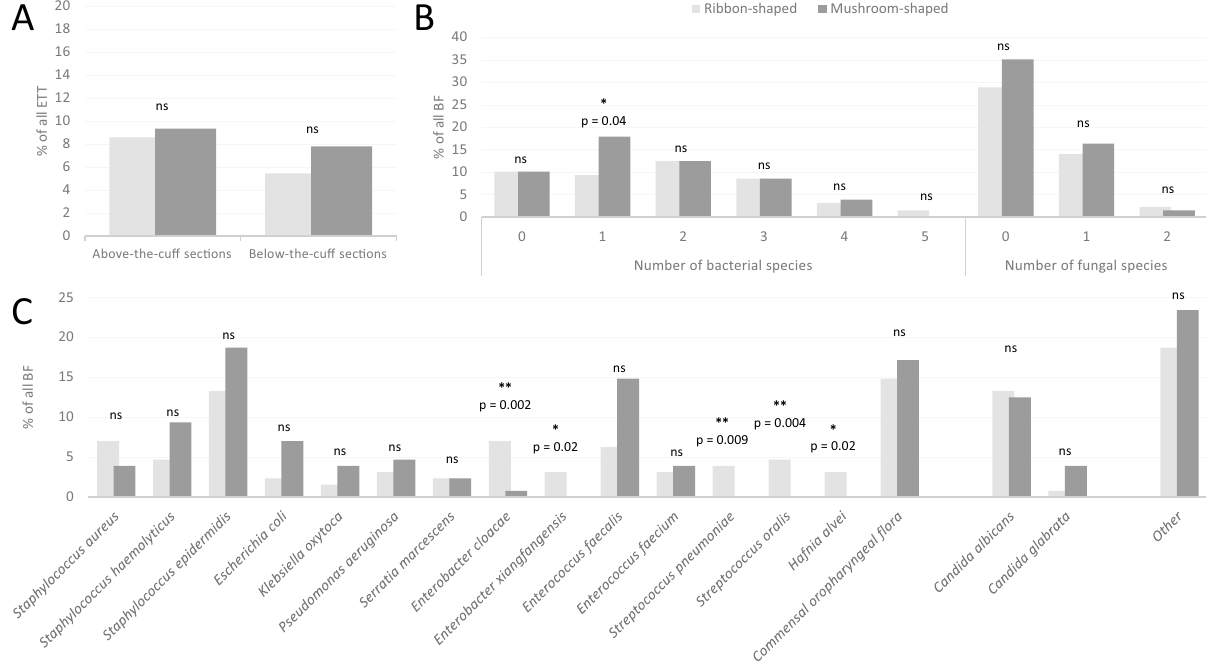
Figure 3. Microbiological characterization of ribbon- and mushroom-shaped ETT-deposited BF. ( A ) compared percentage of ETT retrieving both bacterial and fungal species between ribbon- and mushroom- shaped ETT-deposited BF ; ( B ) compared number of both bacterial and fungal species between ribbon- and mushroom-shaped ETT-deposited BF ; ( C ) compared distribution of both bacterial and fungal species between ribbon- and mushroom-shaped ETT-deposited BF. BF biofilm, ETT endotracheal tube, ns not significant. Other (microbiological species retrieved < 5%) : Candida kefyr , Candida lusitaniae , Candida parapsilosis , Candida tropicalis , Citrobacter freundii, Enterobacter cancerogenus, Enterococcus durans, Klebsiella aerogenes , Klebsiella variicola , Lactobacillus gasseri, Lactobacillus paracasei, Lactobacillus rhamnosus , Morganella morganii, Neisseria mucosa, Propionibacterium acnes, Proteus mirabilis, Pseudomonas oryzihabitans , Raoultella ornithinolytica, Serratia rubidae, Staphylococcus hominis, Stenotrophomonas